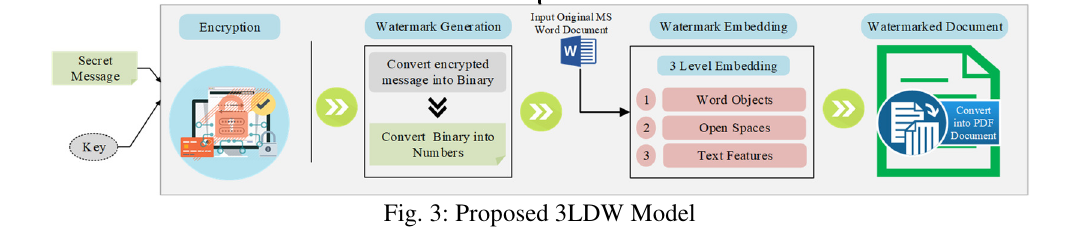
Fig. 3: Proposed 3LDW